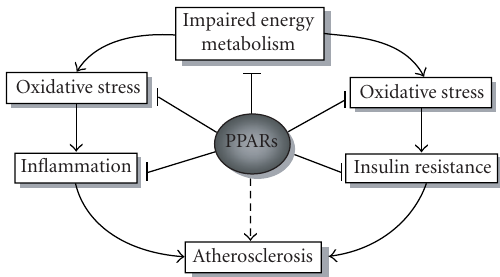
Figure 1: The main pathophysiological processes and their interac- tions leading to aging are depicted. The most likely inhibiting points of PPARs are indicated as possible targets for pharmacological treat- ment. Controversial issue of PPARs on atherosclerosis is marked by broken